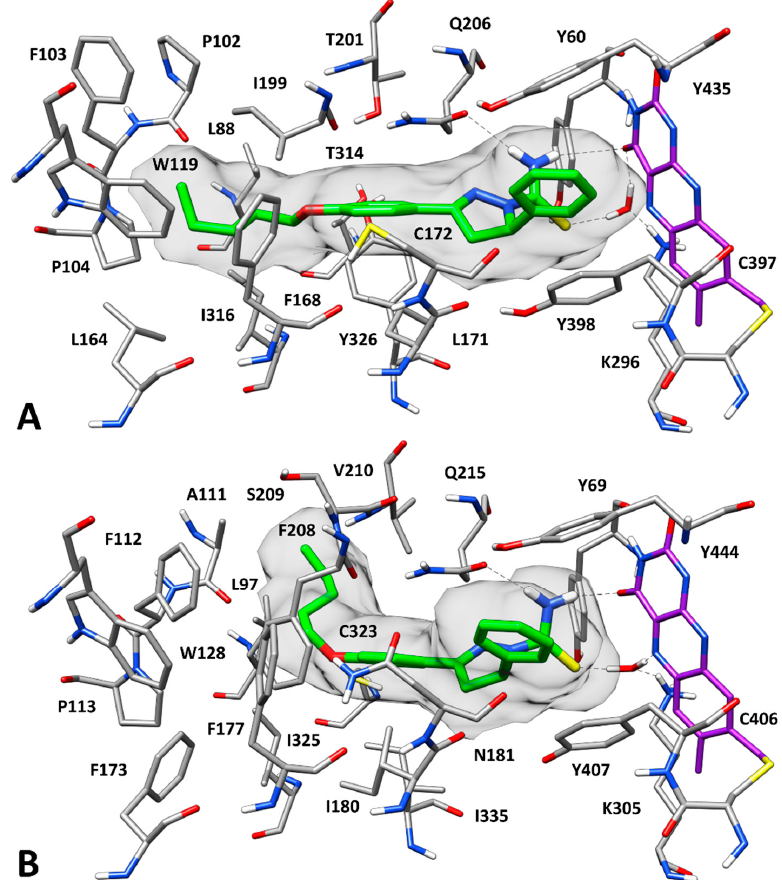
Figure 2. Predicted binding mode of ( R ) ‐ P5 into hMAO ‐ B ( A ) and hMAO ‐ A ( B ). For clarity, only the flavin group of the cofactor is shown in purple. The molecular surface of the ligand is shown in gray. The same computational protocol was then applied to the ( S ) ‐ enantiomer of the inhibitor, which showed a lower activity against both enzyme isoforms. The binding mode predicted for the compound into hMAO ‐ B suggested that, due to the different stereochemistry of the pyrazoline ring, the ligand is not able to form the H ‐ bond network with FAD and Q206 and only the water ‐ bridged interaction with the carbonyl oxygen of the cofactor flavin group and the amino group of K296 is maintained (Figure 3A). However, the terminal phenyl ring of the inhibitor assumes a perfect orientation for the formation of strong π – π stacking interactions with Y398, Y435 and also the flavin group of FAD; moreover, the pyrazoline ring of the ligand can establish additional stacking interactions with the amide group of Q206. These interactions can probably compensate for the loss of the two H ‐ bonds and thus limit the drop of activity of the ligand against hMAO ‐ B with respect to its enantiomer. Differently, the inhibitory potency of ( S ) ‐ P5 on hMAO ‐ A showed a more significant reduction, compared to ( R ) ‐ P5 . Accordingly, the ligand was predicted to assume a binding disposition characterized by an inverted orientation of the pyrazoline core, with respect to the binding mode of its ( R ) ‐ enantiomer. For this reason, none of the H ‐ bonds predicted for the ( R ) ‐